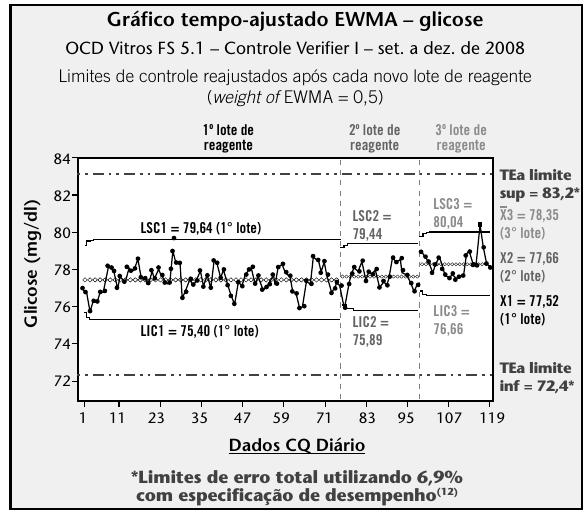
Figura 3 – Análise de imprecisão de longo prazo: gráfico tempo-ajustado EWMA, glicose Vitros FS 5.1, setembro a dezembro de 2008 ( n = 119)